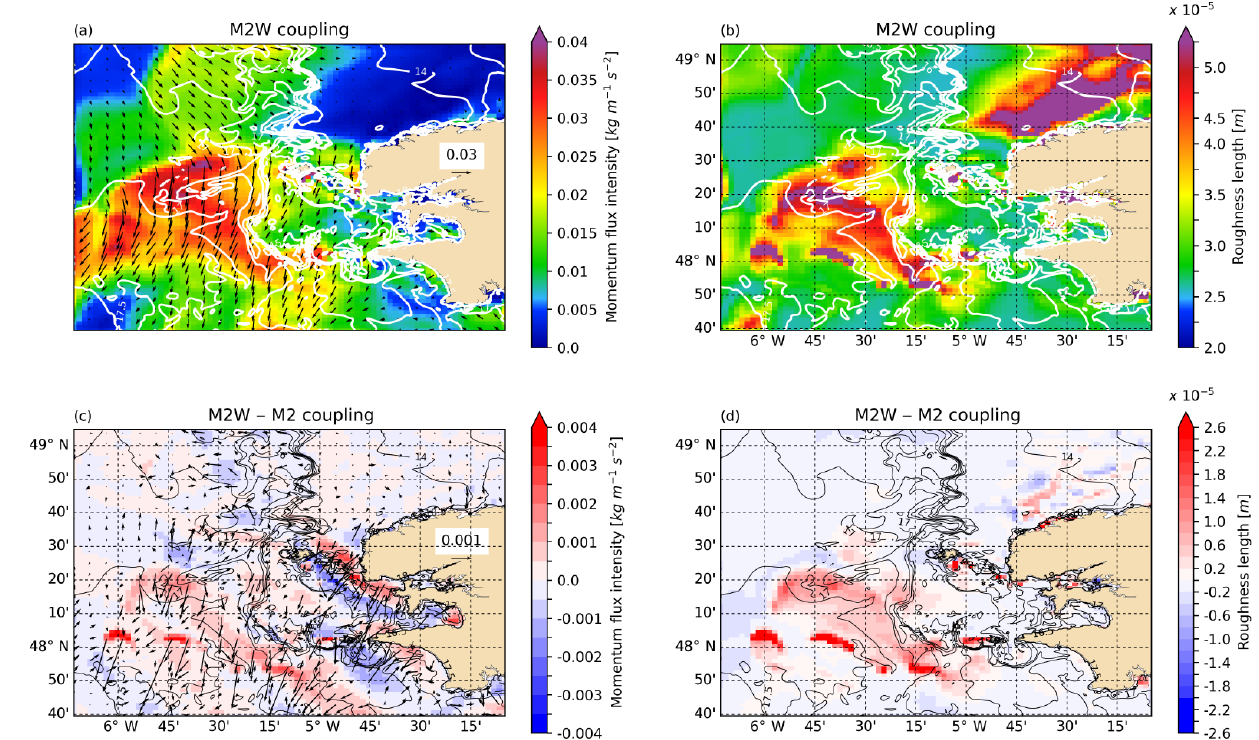
Figure 8. (a) Wind stress module (colour) and vector (arrows) (atmospheric sign convention), and SST (white contours with 0.5 ◦ C interval) simulated by M2W. (b) Roughness length (colour) and SST (white contours with 0.5 ◦ C interval) simulated by M2W. (c) Differences of the wind stress module (colour) and vector (arrows) when simulated by M2W versus M2. (d) Differences of the roughness length (colour) and the SST (black contours with 0.5 ◦ C interval) simulated by M2W versus M2. All fields are shown at 09:00UTC, 2h after high